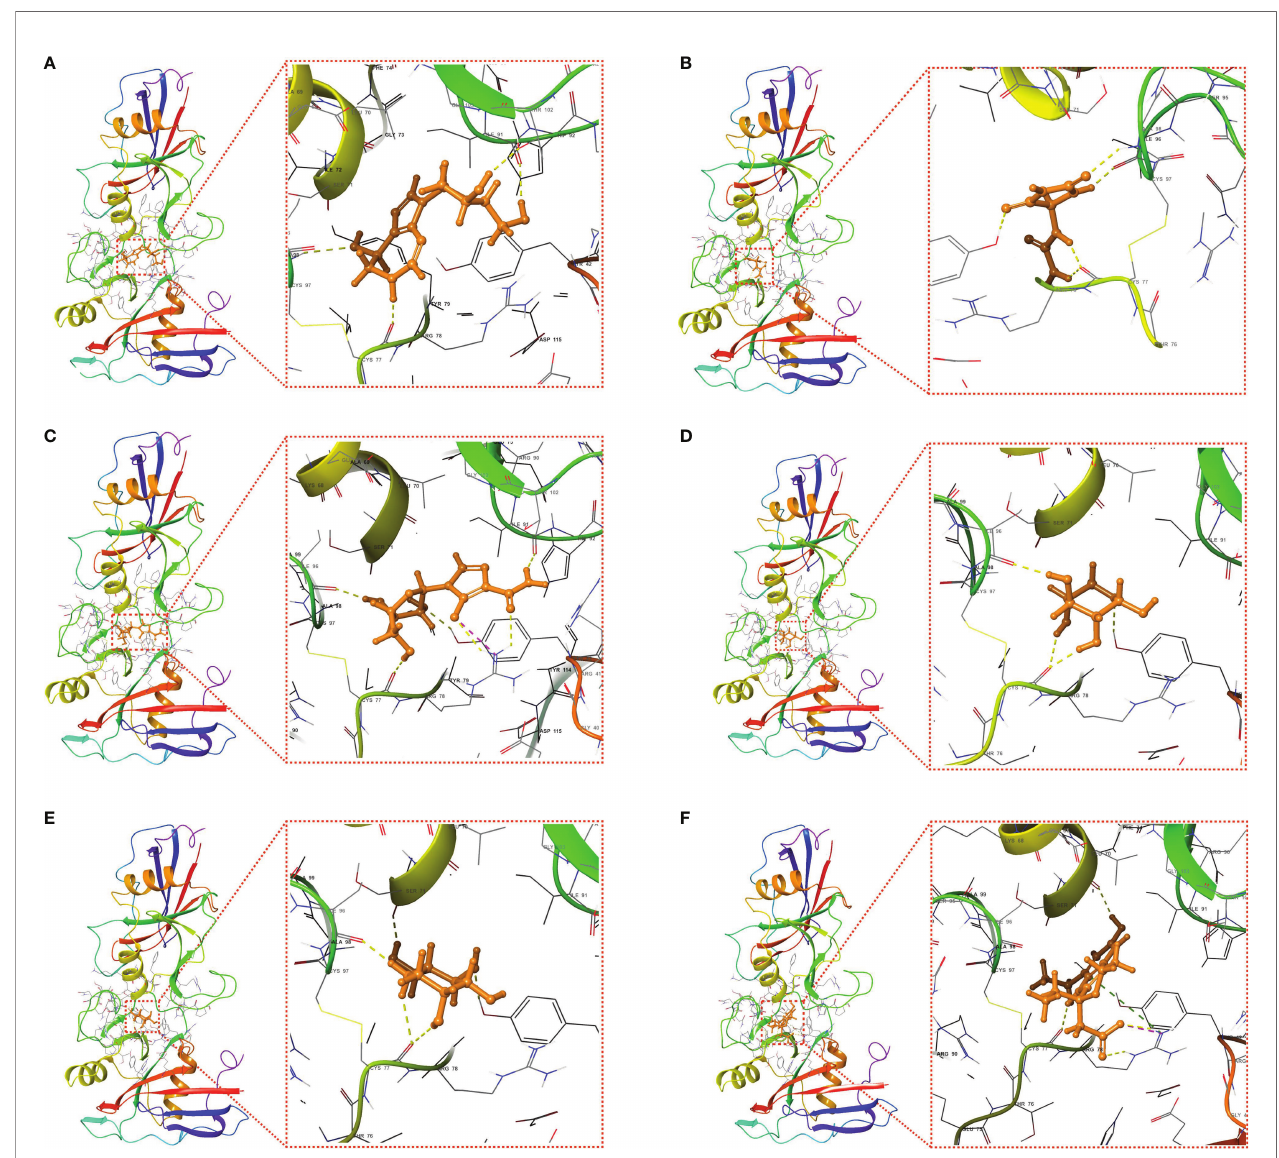
FIGURE 10 | Putative docking models of the six candidate drugs and the core target using molecular docking analysis. 3D structures and binding modes showing the formed hydrogen bonds between the predicted pocket of CD44 and Pentostatin (A) , Allantoin (B) , Mizoribine (C) , Xylose (D) , Deoxynojirimycin (E) , and 6- Hydroxyetodolac (F)